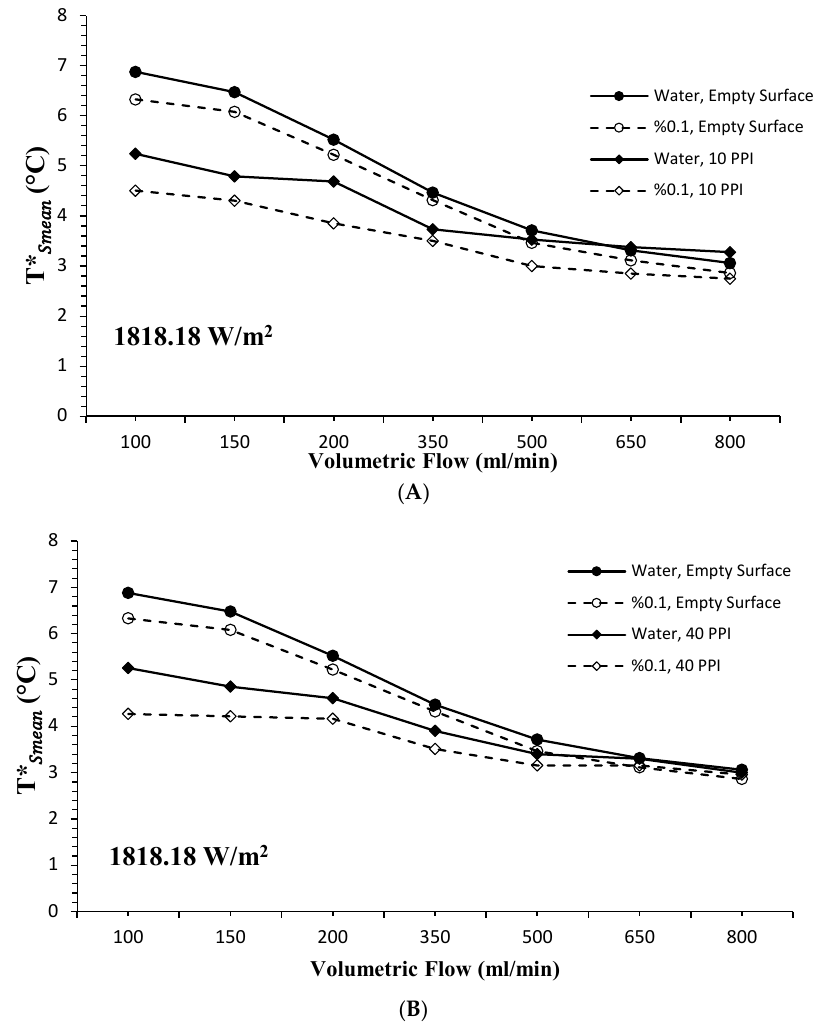
Figure 6. Mean surface temperatures versus volumetric flow rates with different PHSs ( A ) 10 PPI, ( B ) 40 PPI.